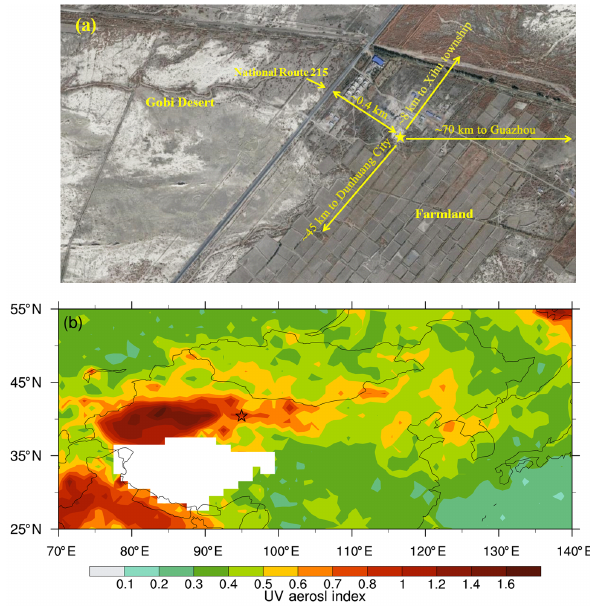
Figure 1. (a) The Dunhuang farmland site (40.492 ◦ N, 94.955 ◦ E; altitude: 1061m) labeled with a star and its surrounding region. (b) OMI (Ozone Monitoring Instrument, 2004) mean UV aerosol index from 1 April to 12 June 2012. The site is located in the downwind region of the Taklamakan Desert and frequently experiences dust